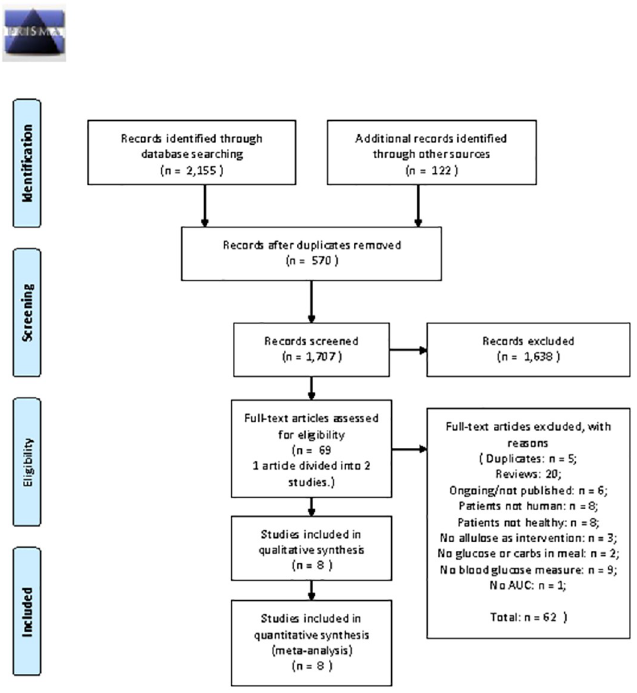
Fig 1. PRISMA 2009 flow diagram. From : Moher D, Liberati A, Tetzlaff J, Altman DG, The PRISMA Group (2009) P referred R eporting I tems for S ystematic Reviews and Meta- A nalyses: The PRISMA Statement. PLoS Med 6(7): e1000097. doi:10.1371/journal.pmed.1000097 For more information, visit www.prisma-statement.org.